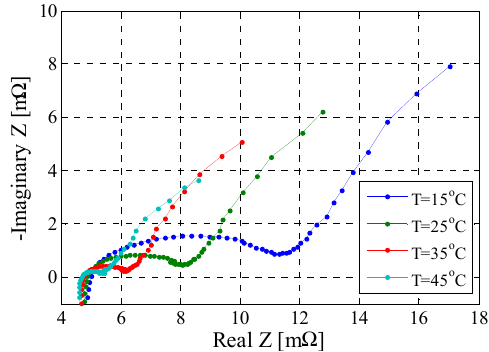
Figure 11. Dependence of the impedance spectra on the temperature; SOC = 50%.